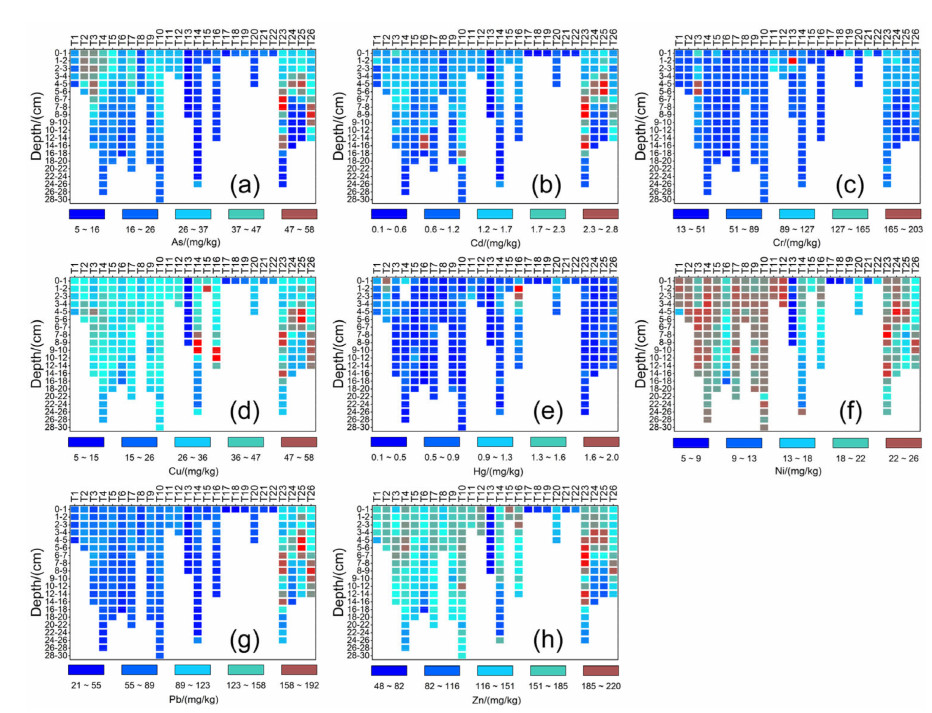
Figure 2. Distribution of heavy metals in sediments of Tongjiqiao Reservoir. ( a – h ) represent different heavy metals of As, Cd, Cr, Cu, Hg, Ni, Pb, and Zn, respectively. Heavy metal accumulation in the D region may be the result of incoming pollutants that migrate with the flow field and hydrodynamic conditions and then settle in front of the dam. The accumulation of pollutants in the SW region may be related to the development of processing and manufacturing industries in the surrounding villages and towns. Addi- tionally, the concentrations of As (22.18 mg/kg), Cd (0.90 mg/kg), and Cr (46.69 mg/kg) in the CE region were second only to those in the D and SW regions, indicating that